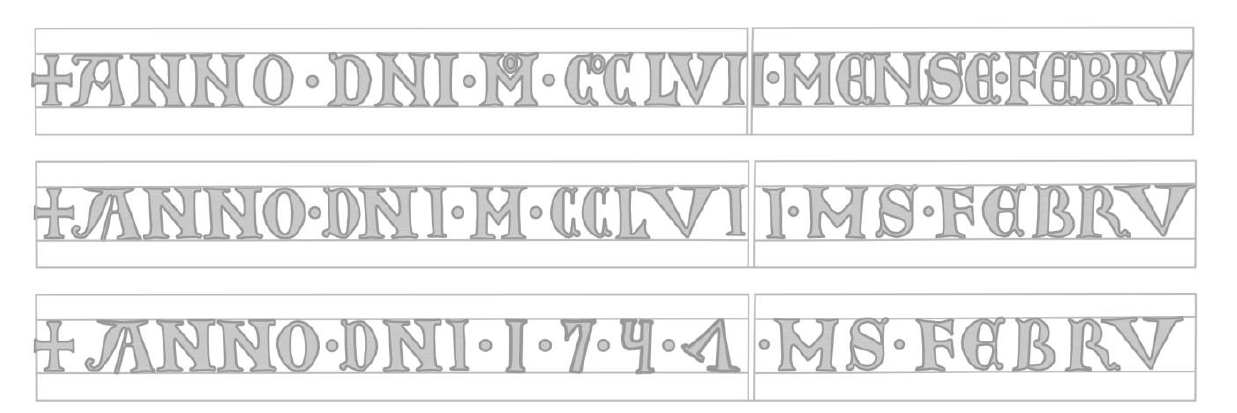
Figure 12. Graphical reconstruction of the inscription’s first two stones; above: existing stock of the 19th century replacement, middle: Reconstruction of the medieval stock using the medieval letters and the abbreviation MS instead of MENSE, below: Reconstruction of the medieval stock using Arabic